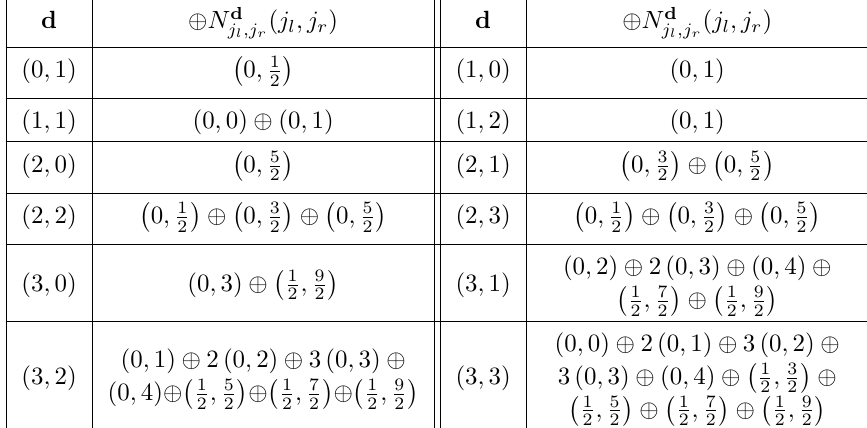
Table 26. BPS spectrum of P 2 ∪ F 6 for d i ≤ 3 . Here, d = ( d 1 , d 2 ) labels the BPS state with charge d 1 ‘ + d 2 f 2 .